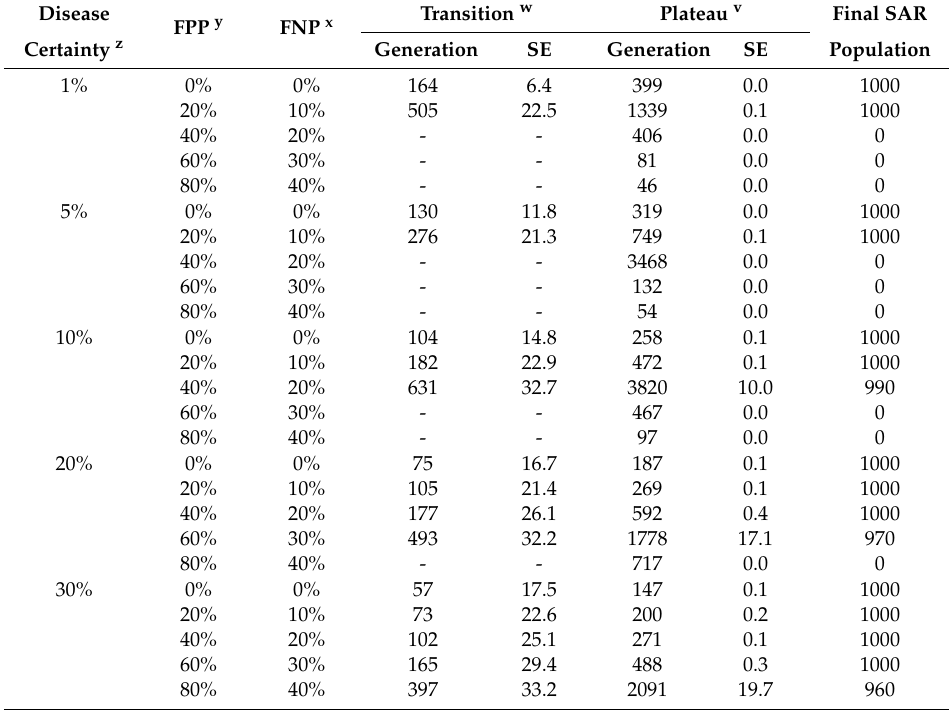
Table 3. Simulation dynamics and final population size for hypothetical plant populations with systemic acquired resistance (SAR) after competition with hypothetical population without SAR for at least 1000 generations where constitutive resistance alone is less fit in absence of disease; averages are from 100 runs of a game theory model based on a meta-analysis on fitness costs of SAR. Disease Transition w Plateau v Final SAR FPP y FNP x Certainty z Generation SE